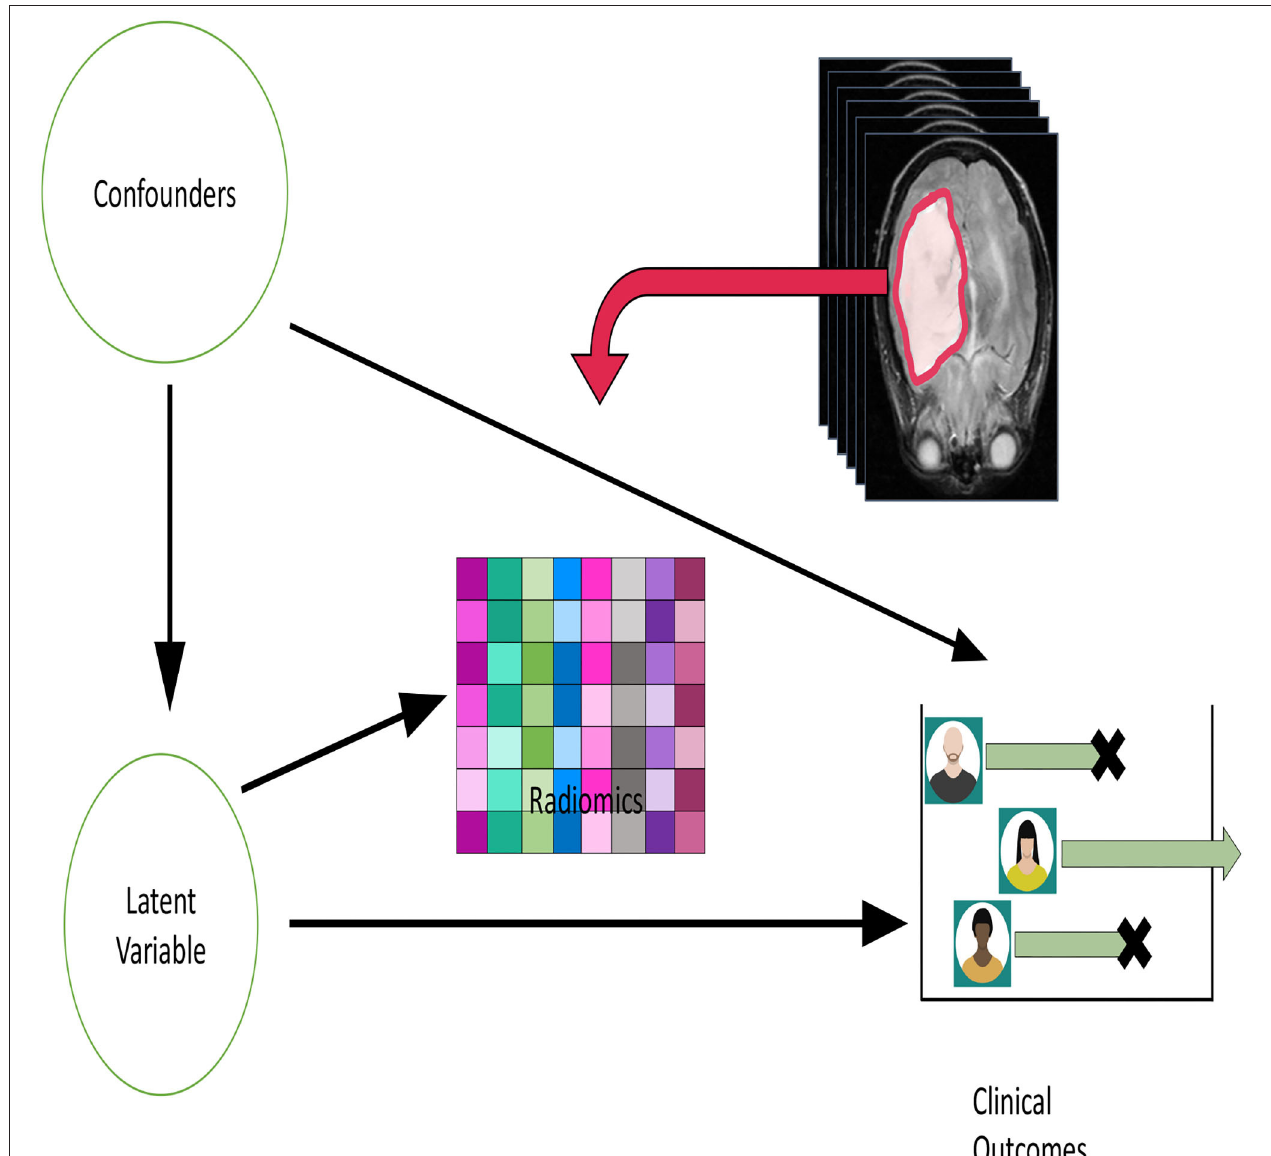
FIGURE 1 | A conceptual model diagram relating confounders, radiomics and outcome variables in medical studies. The goal is to estimate the causal effect corresponding from the arrow from the “Latent variable” circle to the clinical outcome.